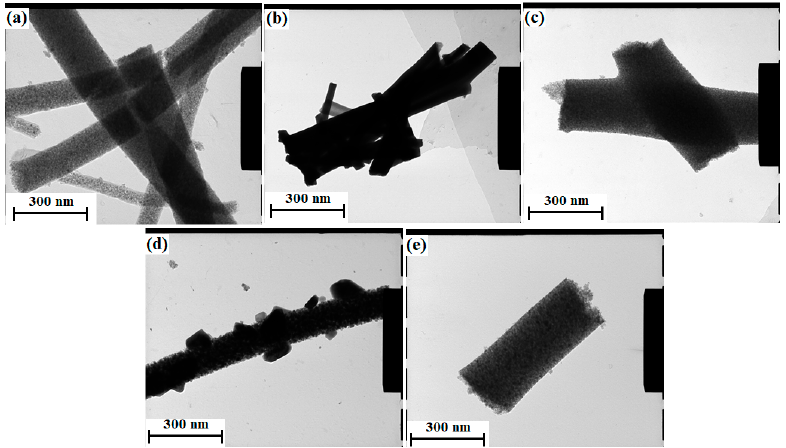
Figure 4. TEM photographs of fibers after annealing: ( a ) 100% TiBALDH, ( b ) 90% TiBALDH, ( c ) 50% TiBALDH, ( d ) 10% TiBALDH, and ( e ) 0% TiBALDH.